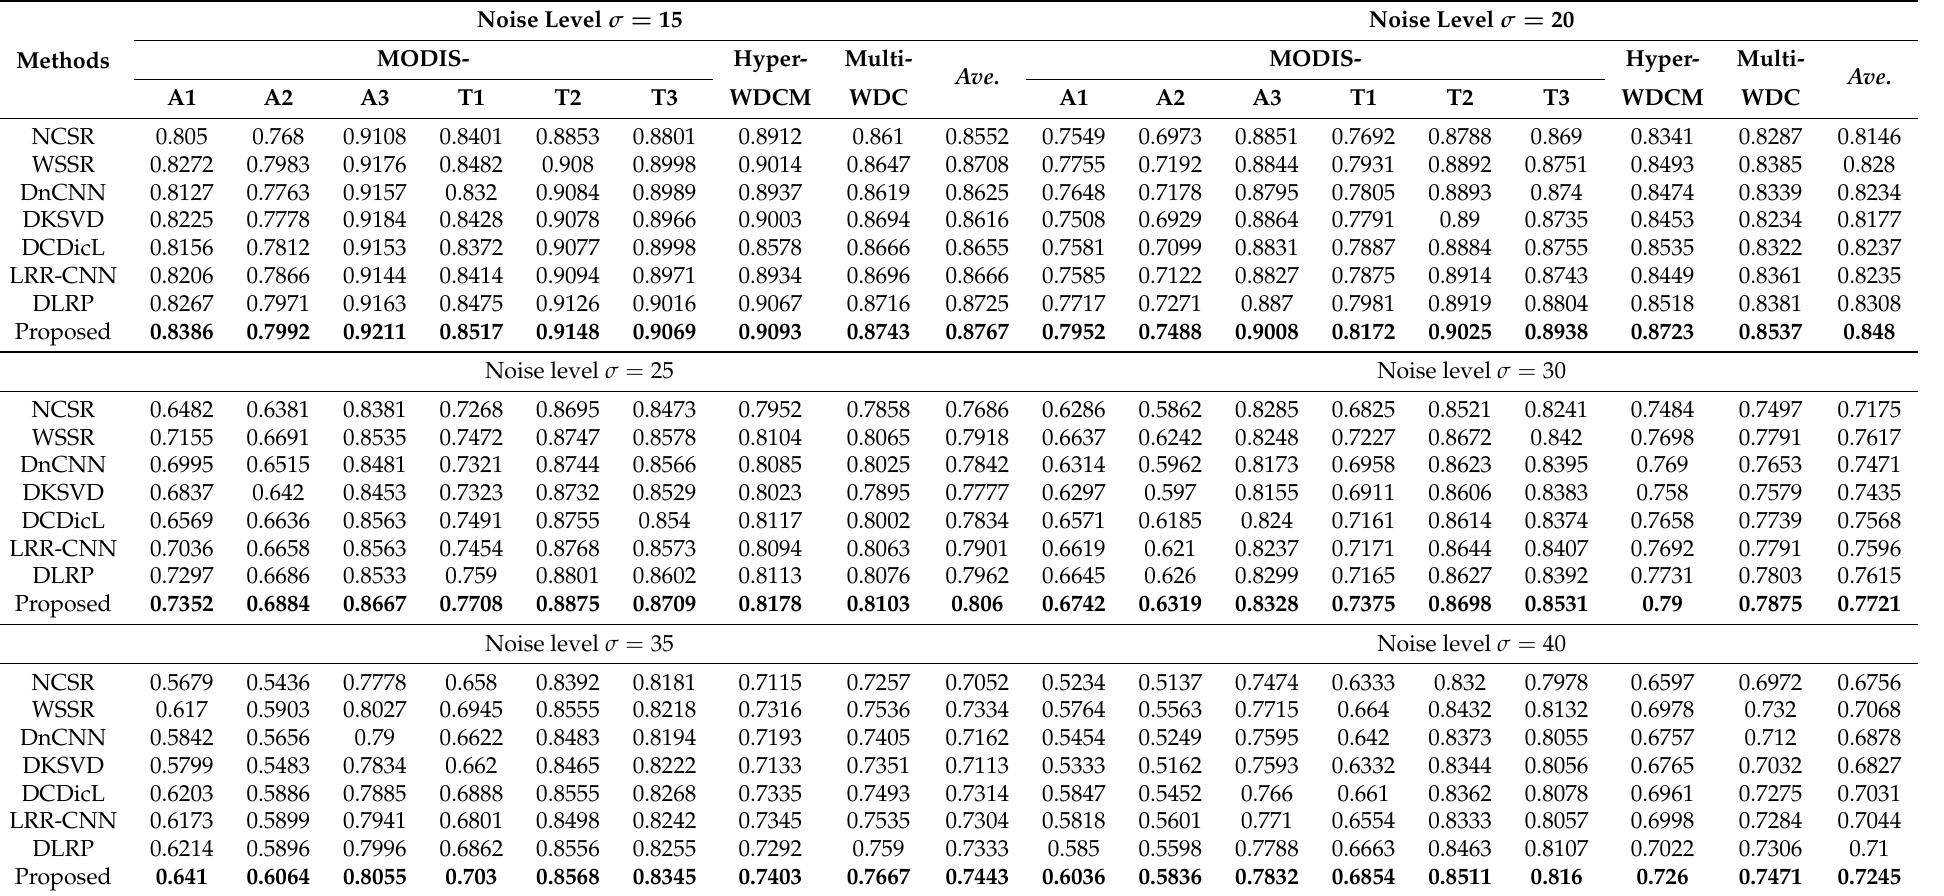
Table 2. SSIM comparisons of the state-of-the-art. For each image at each level, the best result is marked with bold